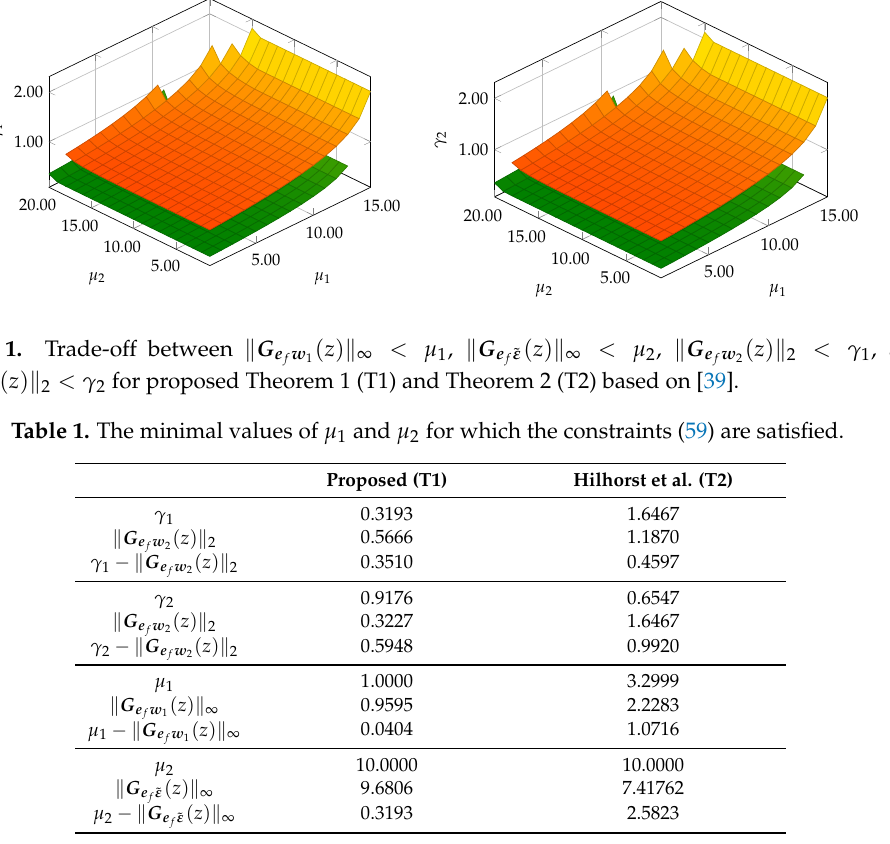
( z ) < γ G e 1 , and f w 2 (cid:107) (cid:107) 2